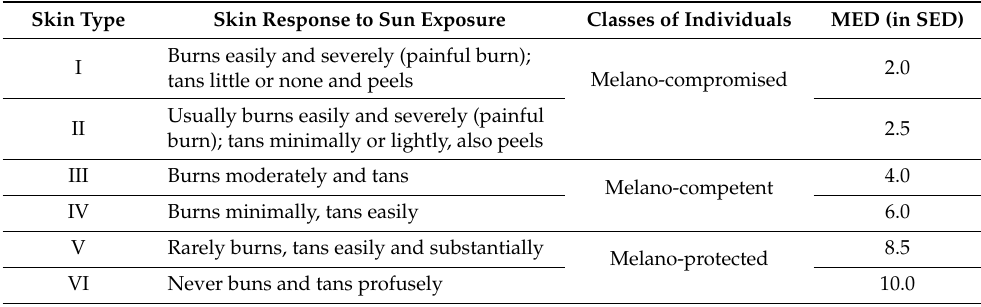
Table 1. Column 1: Fitzpatrick skin types [21], column 2: specific skin response to sun exposure